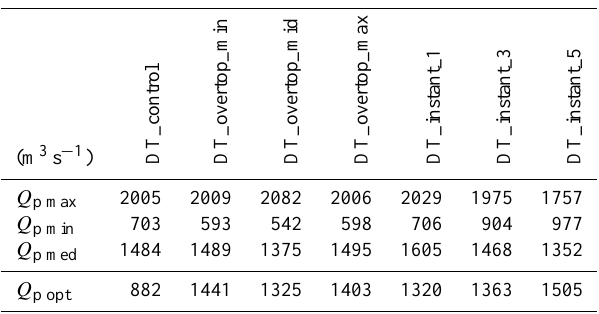
Table 3. Scenario-specific maximum ( Q p max ), minimum ( Q p min ), median ( Q p med ), and optimal ( Q p opt ) peak discharges.